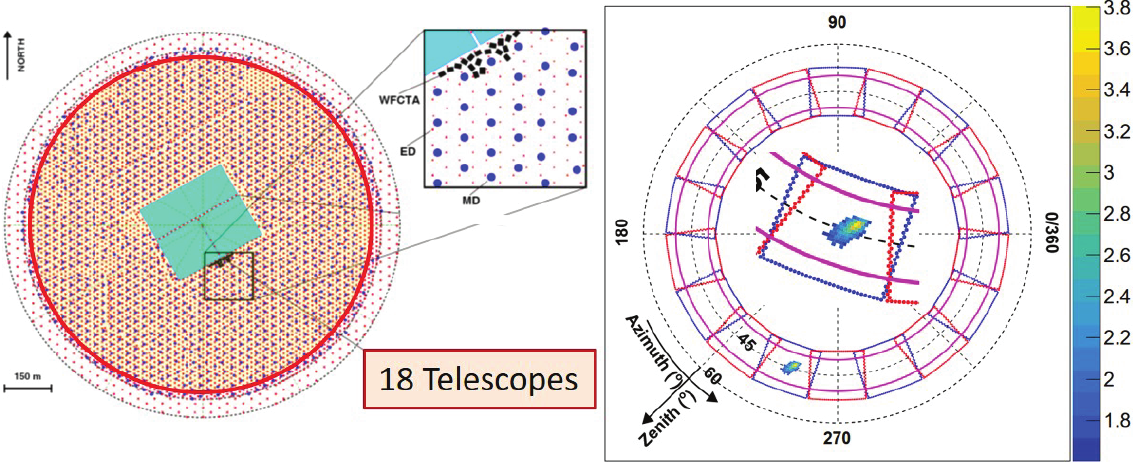
Figure 3. The configuration of LHAASO hybrid operation for cosmic ray observation after July 2021. The layout of all detectors is shown in the left panel. The FoV of the 18 WFCTs is shown in the right panel in the same coordinate system as in Figure 2. It is clearly seen that telescopes form a boundary-less FoV in the azimuthal direction between zenith angles 37 ◦ and 53 ◦ . Two zenith angle contour lines in pink indicate the event selection criteria images having heads between them, are well measured showers. The FoV of the telescope that has a shower image recorded is enlarged and put in the middle of the panel as an inset.